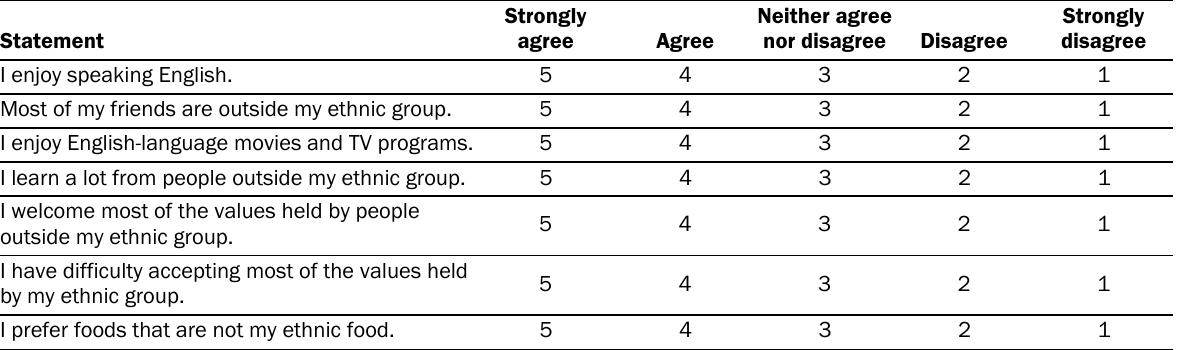
Table 1. Ethnic Canadian Dietary Acculturation